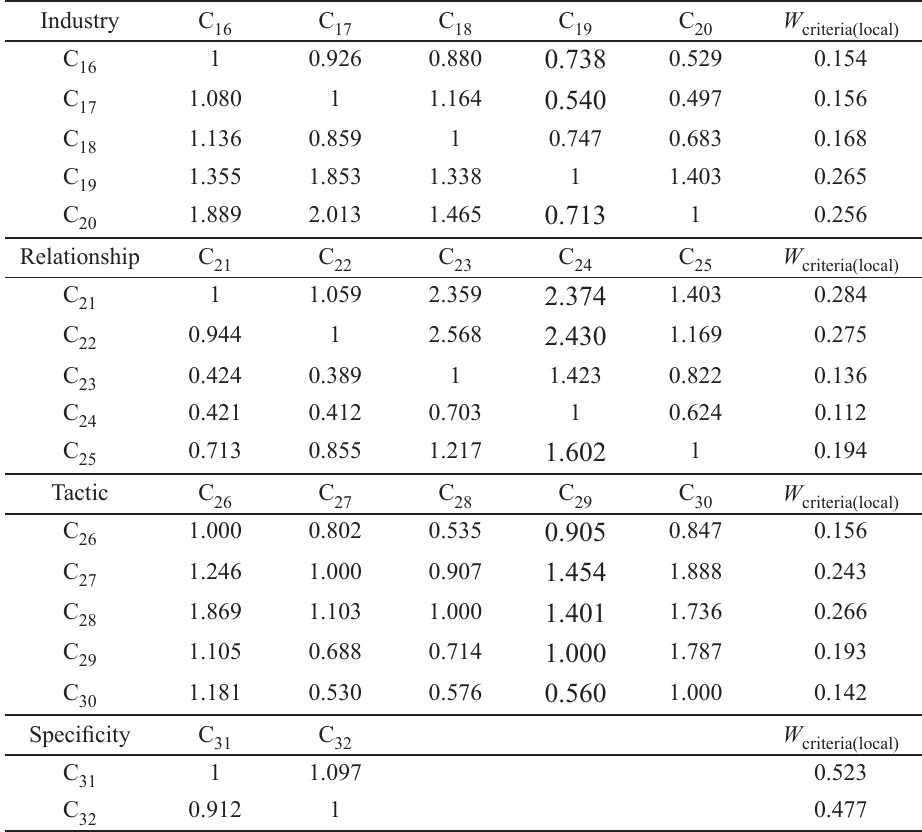
Table 7. The relative importance weights